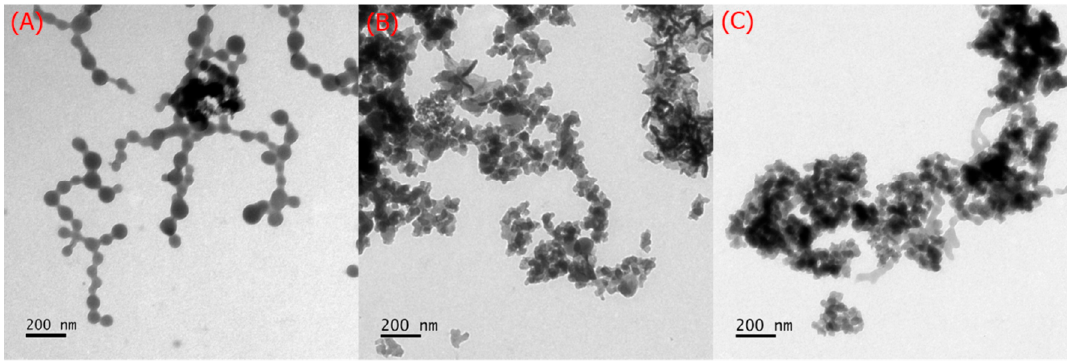
Figure 8. TEM images for the calcined MCM-41 materials: Si-MCM-41 ( A ); Ce-MCM-Cl ( B ); and Ce-MCM-NO 3 ( C ).